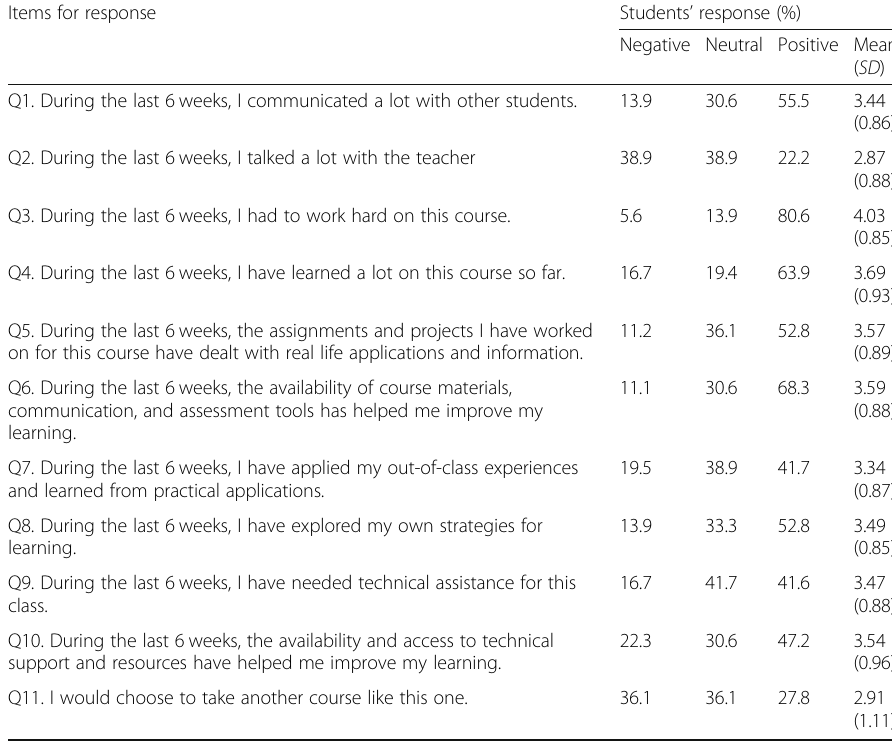
Table 1 Post-task survey items and results concerning students ’ experience of the MOOC-based flipped learning Items for response Students ’ response (%)